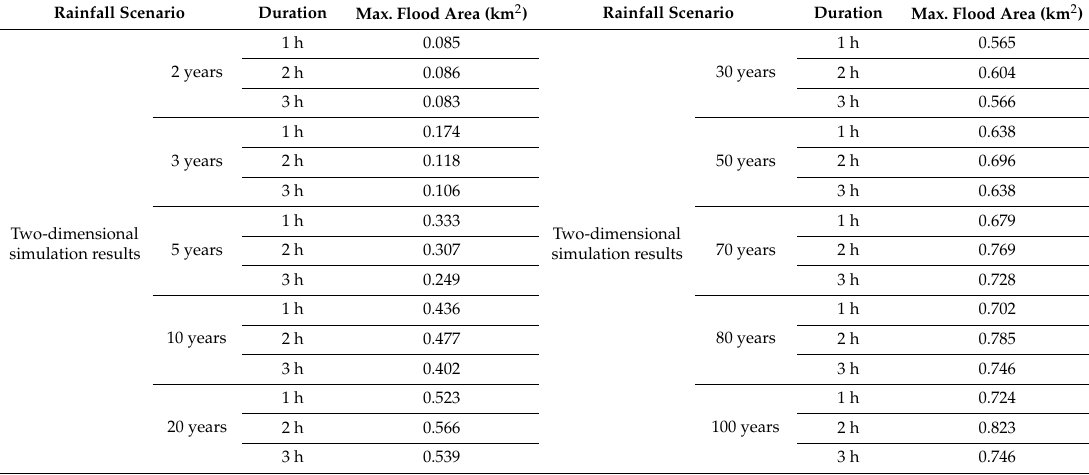
Table 3. Maximum flood area of SOM input data inundation map.